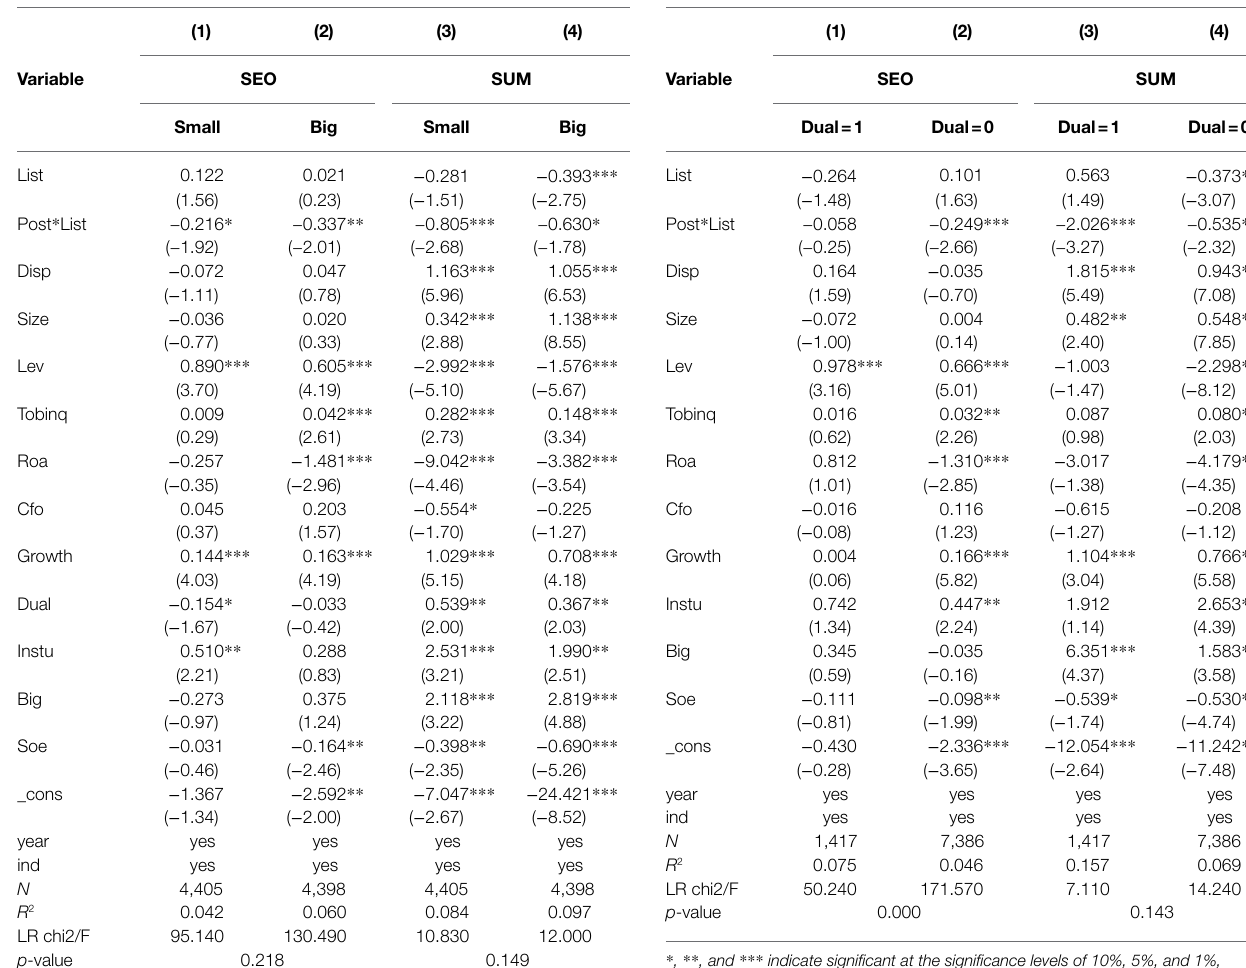
TABLE 6 | Deregulation of short selling and private placement of companies: the size of financing constraints.